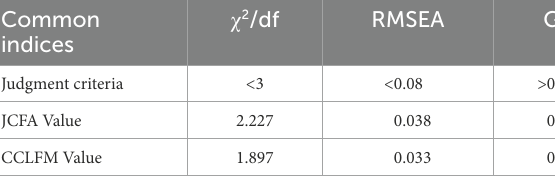
TABLE 8 Model fitting index comparison results of CFA and CCLFM. Common